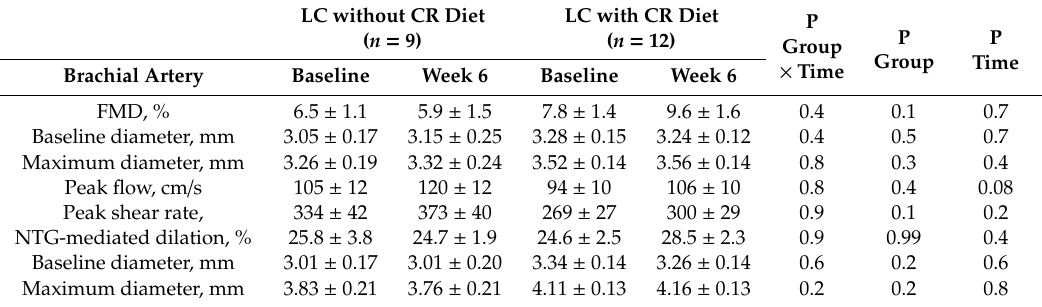
LC without CR Diet ( n = 9)